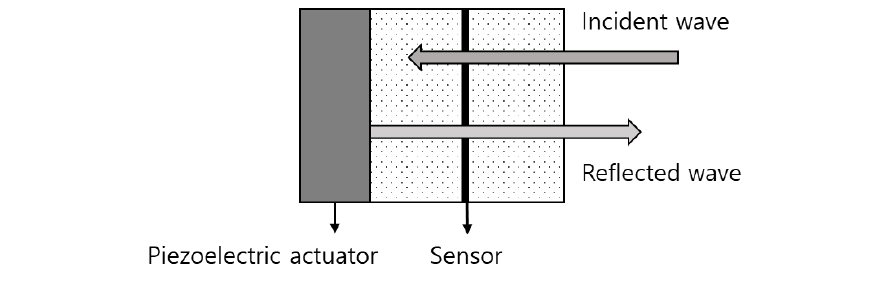
Figure 8. Concept of active noise control.